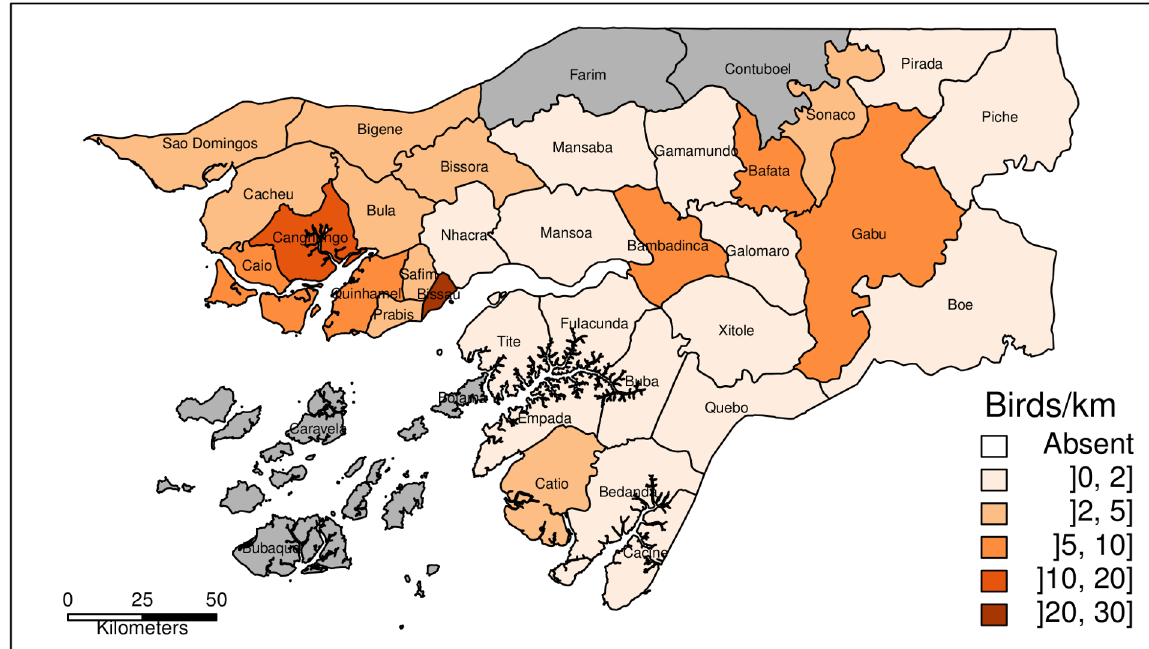
Fig 2. Abundance of Hooded vultures. Abundance of Hooded vultures Necrosyrtes monachus in sampled Sectors of Guinea-Bissau obtained from road survey transects. Grey areas represent Sectors that were not sampled (yet Hooded vultures are present and widespread in the Bijago´s archipelago; authors pers. obs.).